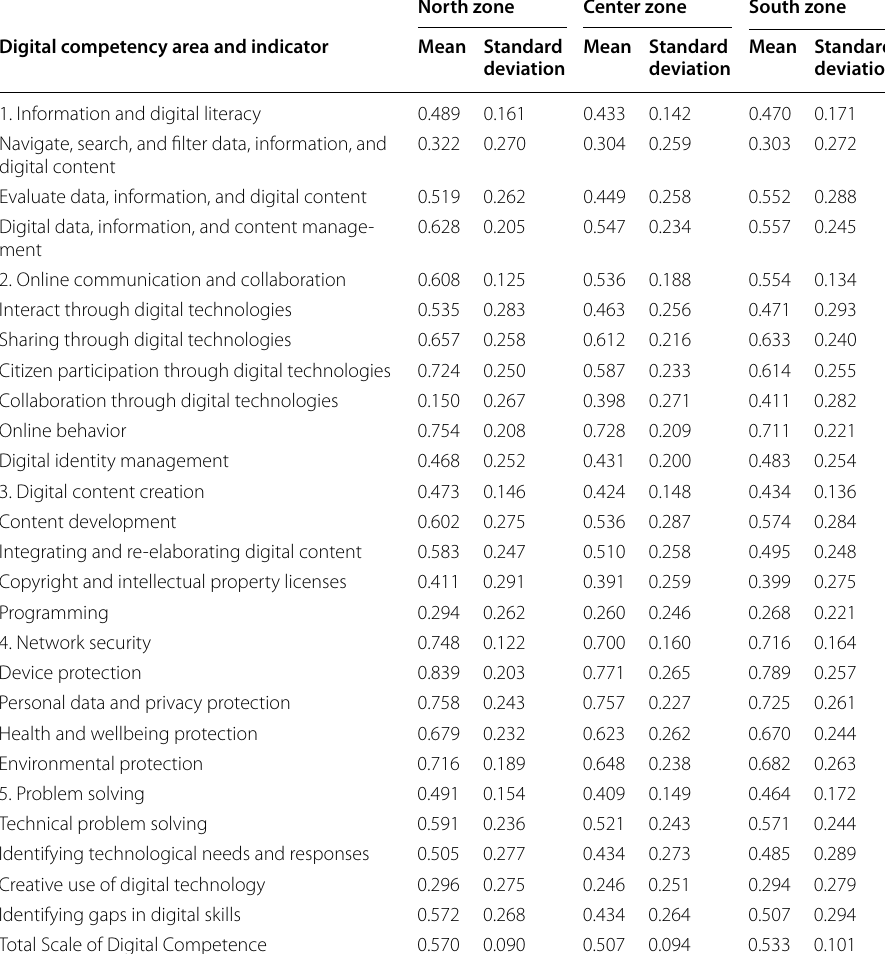
Table 5 DC level by university admittance. Source: Prepared by the author Digital competency area and indicator Mean Standard